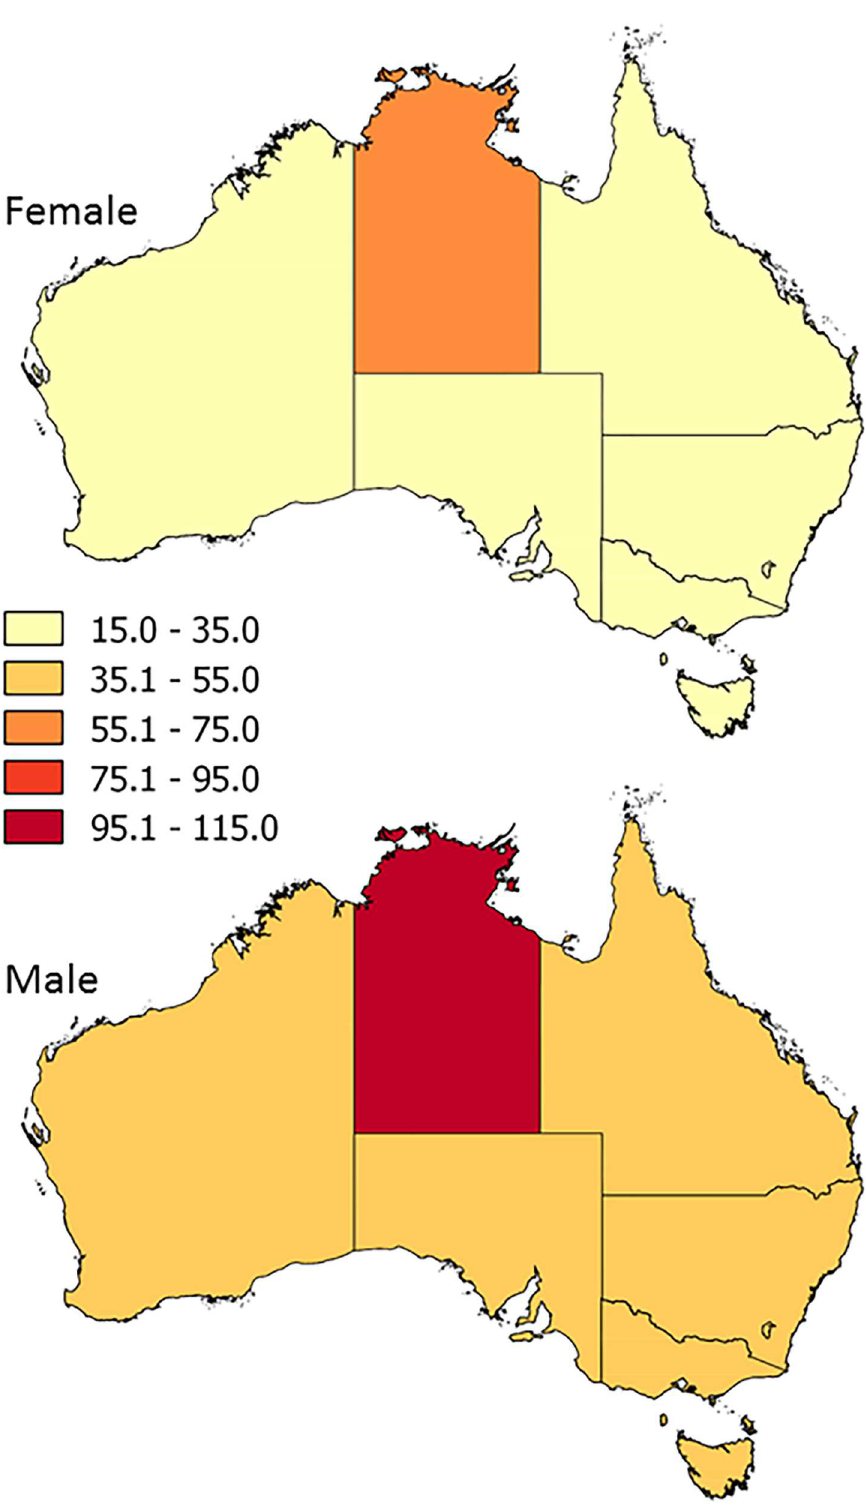
Fig 1. Geographic variation in the age-adjusted incidence rate of lower limb amputation for females (top) and males (bottom) across Australia from 2007–8to 2011–12. Incidencerates expressedper 100,000populationby